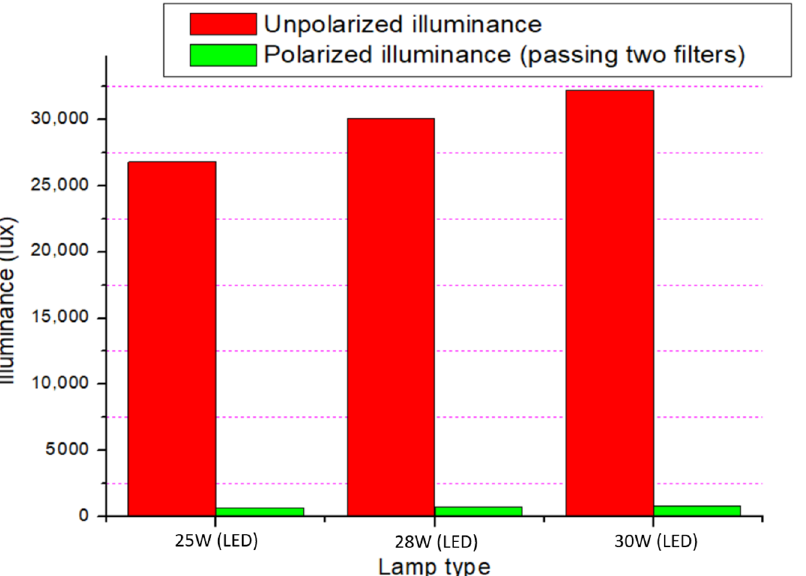
Figure 5. Illuminance measurements of LED headlights with different powers (25 W, 28 W, and 30 W). Polarized measurements are taken after light passed through both the polarized headlights’ filter and flip plate.